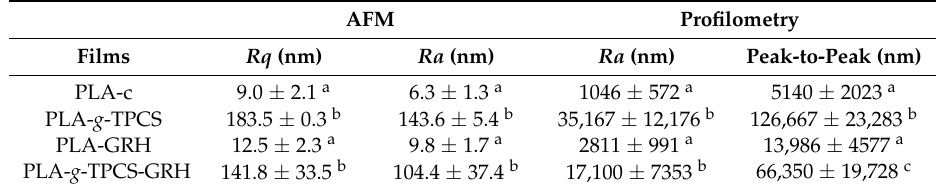
Table 4. Roughness of PLA films as measured by AFM and profilometry.